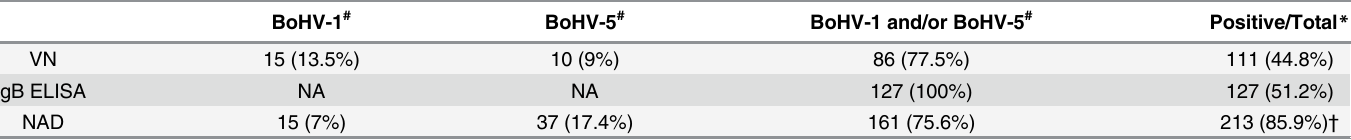
Table 1. Detection of antibodies to BoHV-1 and / or BoHV-5 in serum [virus neutralization (VN) and gB ELISA] and nucleic acid detection (NAD) in trigeminal ganglia (TG) of slaughtered cattle (n = 248). BoHV-1